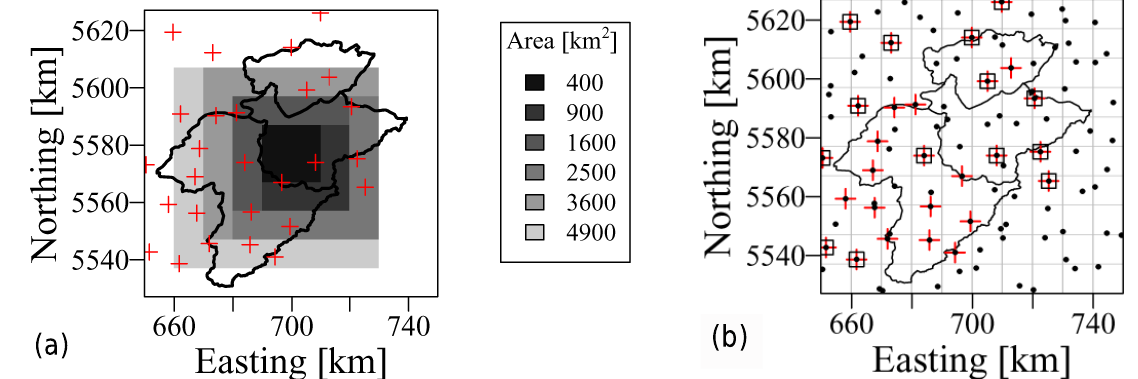
Fig. 6. (a) Six nested “sub-catchments” with increasing catchment areas. Rain gauges are indicated by plusses. (b) Three types of rain gauge densities: dots ( N =100), red pluses ( N =27) and squares ( N =14). Extent of figure corresponds to the black dashed box in Fig. 5 and the grey lines show the 10km × 10km grid